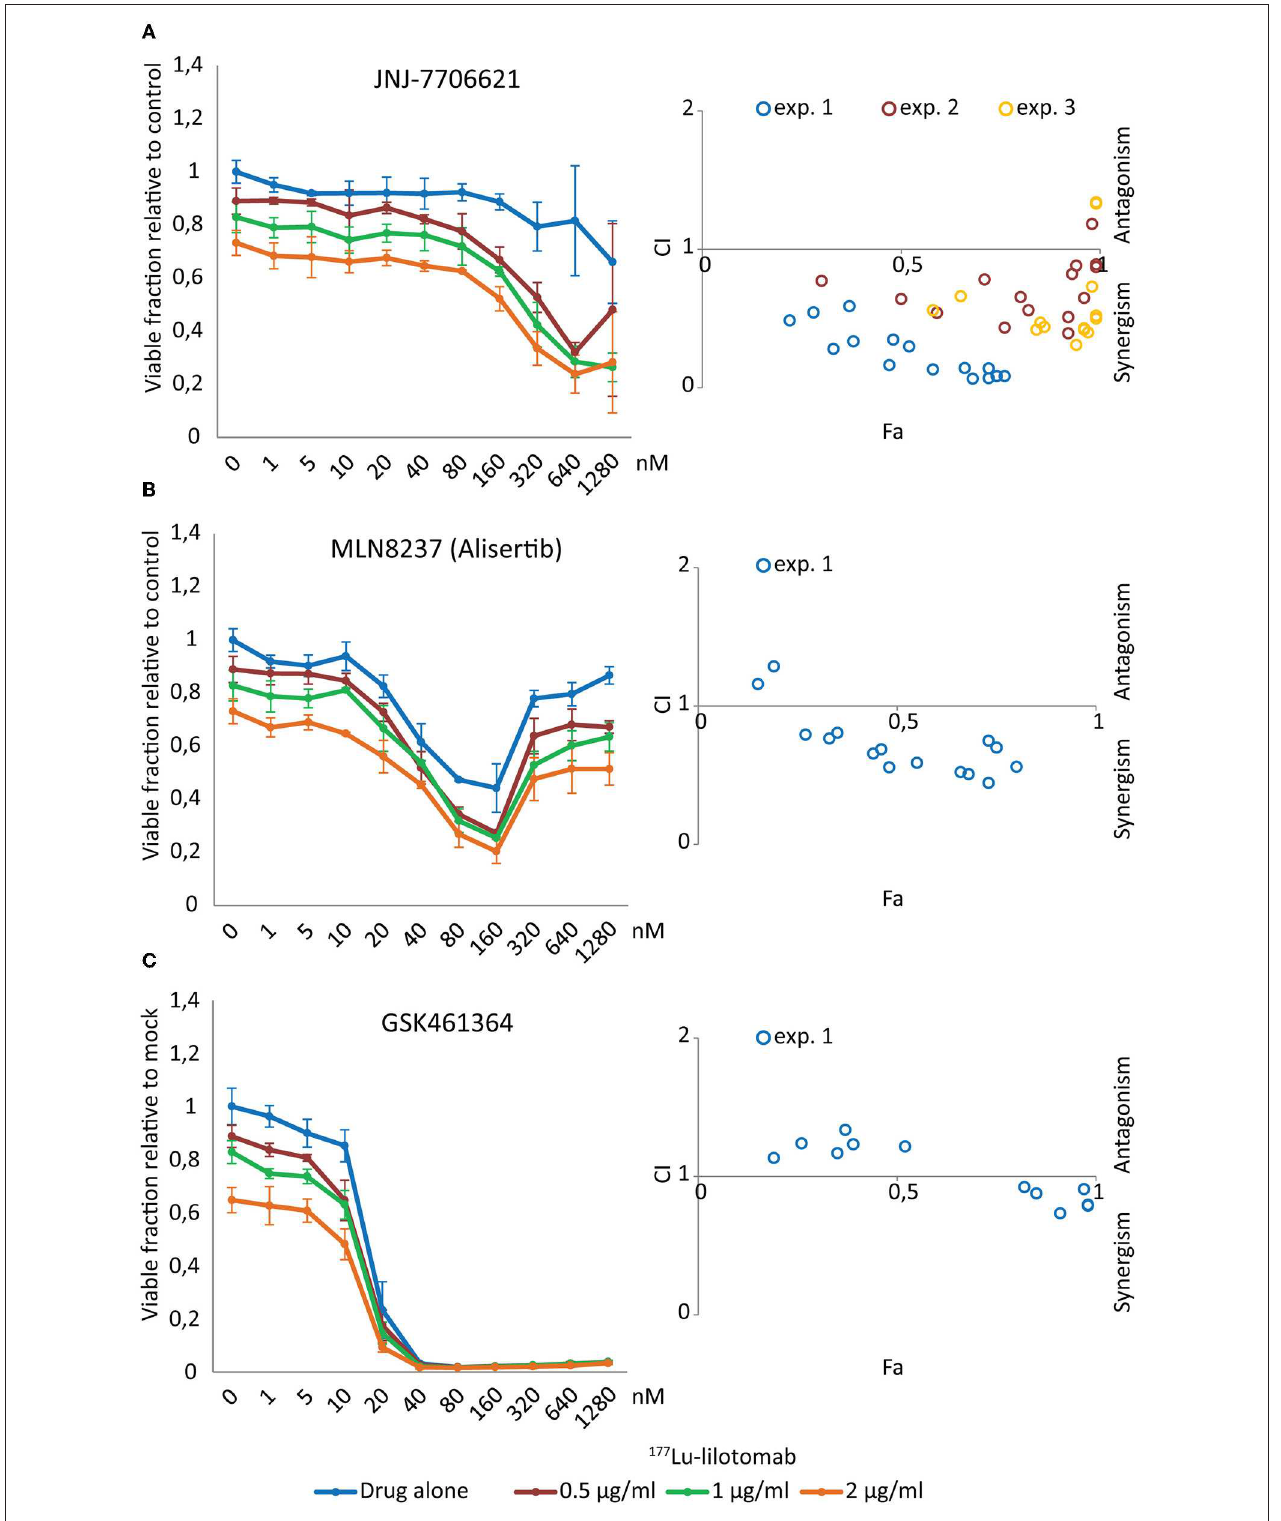
FIGURE 4 | JNJ-7706621 synergistically reduces viability of U-2932 cells when combined with 177 Lu-lilotomab satetraxetan. U-2932 cells were treated with 0.5, 1, and 2 µ g/mL 177 Lu-lilotomab satetraxetan as in Figure 1 and seeded in 384-well plates pre-printed with JNJ-7706621, Alisertib, and GSK461364 in an 11